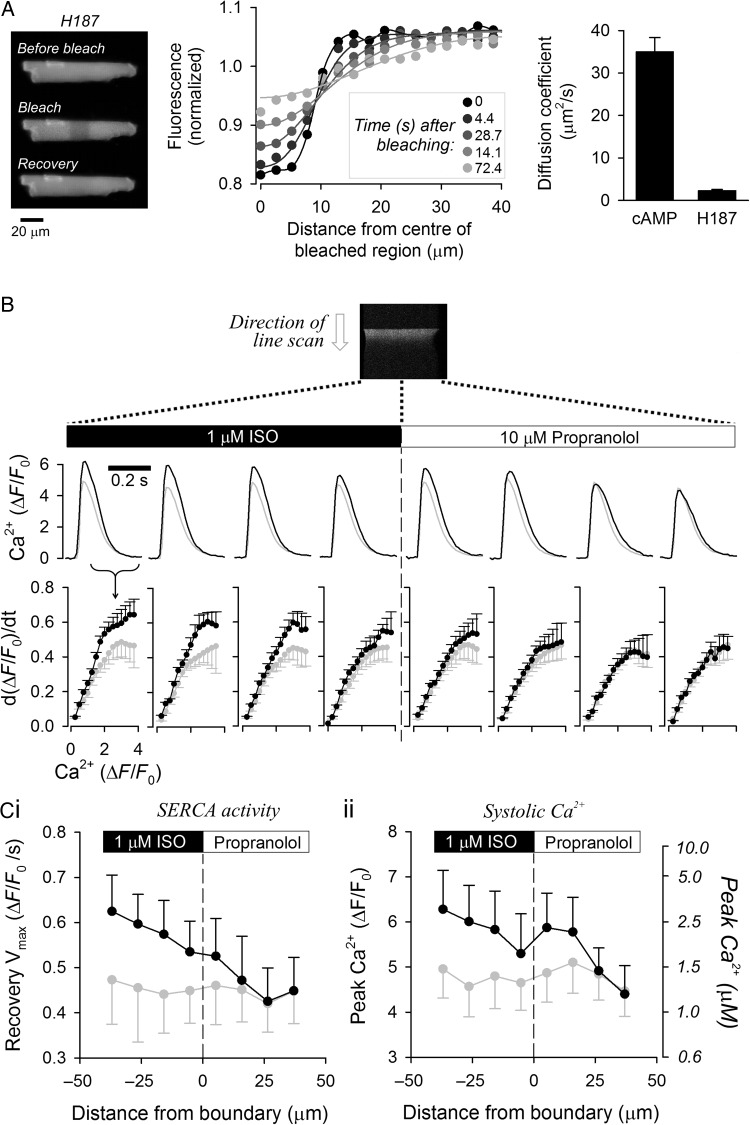
H187 does not interfere with the rate of cAMP diffusion. (A) Fluorescence recovery after photobleaching (FRAP) protocol for measuring H187 diffusivity in adult cardiac myocytes. Bleaching was performed in a 20 µm-wide region in the middle of the cell. Spatial profiles show fluorescence as a function of distance from the bleaching region at different time points during recovery. Continuous lines show best fit by diffusion model. H187 diffusivity (n = 17/3) was 15-fold slower than DcAMP measured in Figure 1; therefore, H187 cannot meaningfully accelerate cAMP diffusion. (B) Using SERCA activity as a bioassay of [cAMP] in adult cardiac myocytes that are not expressing H187. Cell paced at 2 Hz and imaged for [Ca2+] with Fluo3 fluorescence in line scan mode. Ca2+ transients (CaTs) measured in line scan sections on either side of boundary between ISO-containing and propranolol-containing microstreams. (B) Rate of CaT recovery as a function of [Ca2+] provides a measure of SERCA activity before (grey) and during (black) dual microperfusion (n = 9/2). Activation of flux indicates that cAMP had activated SERCA pumps locally. (C) (i) Peak recovery of CaT and (ii) systolic [Ca2+] measured before (grey) and during (black) dual microperfusion (n = 9/2). Right axis shows calibrated units, with Fluo3 Kd = 840 nM. The longitudinal profiles of SERCA activity (in the absence of H187 sensor) are comparable to longitudinal [cAMP] profiles reported with H187 (see Figure 1Dii), indicating that H187 does not slow cAMP diffusion.